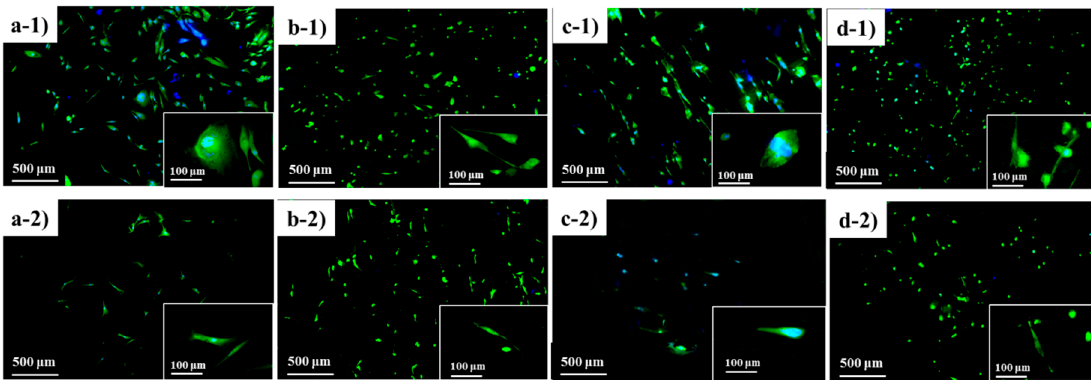
Figure 9. Dual staining of fluorescein diacetate-4’,6-diamidino-2-phenylindole ( FDA / DAPI) for biocompatibility study: ( a-1 , a-2 ) control group (TCP); ( b-1, b-2 ) PCL 6 –PDMS 4 ; ( c-1, c-2 ) PCL 7 – PDMS 3 ; and ( d-1 , d-2 ) PCL 8 –PDMS 2.